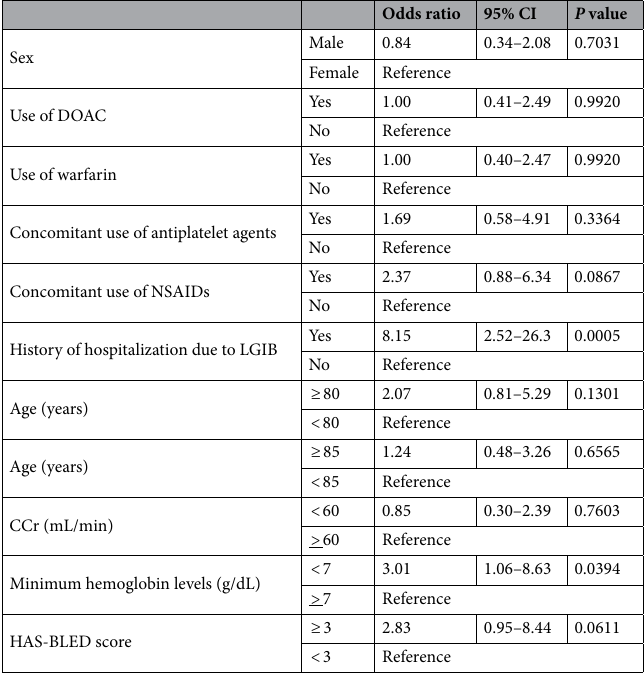
Table 7. Univariate logistic analysis for risk factors for readmission within 1 year. CI: confidential interval, LGIB: lower gastrointestinal bleeding caused by colonic diverticular